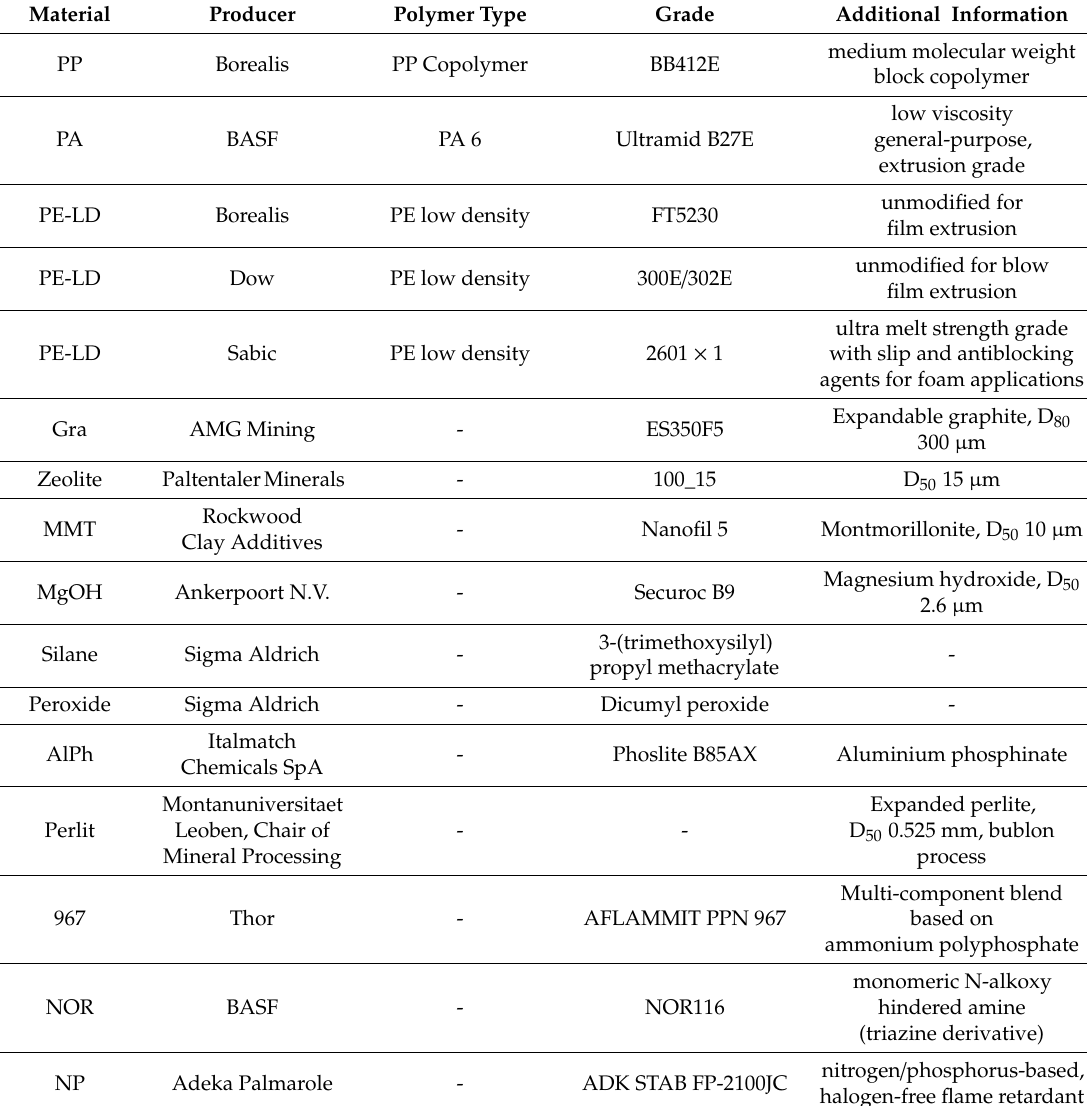
Table 1. Specification of